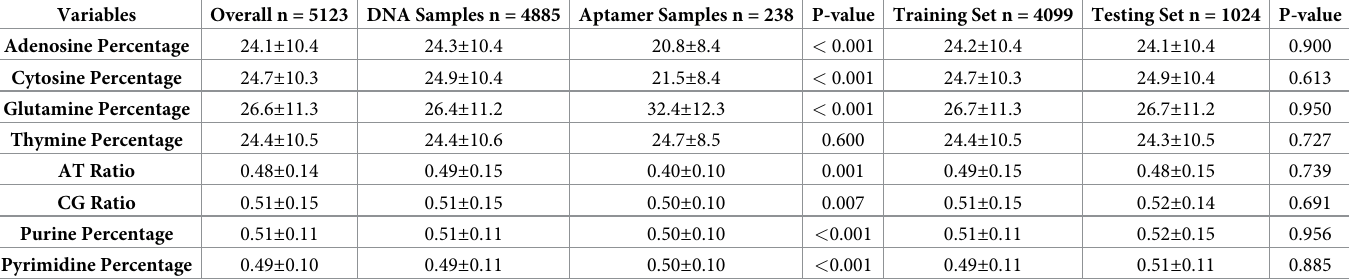
Table 2. Characteristics and other information of the other features/variables that corresponds to DNA and aptamer sequences (data are presented as Mean ± SD).